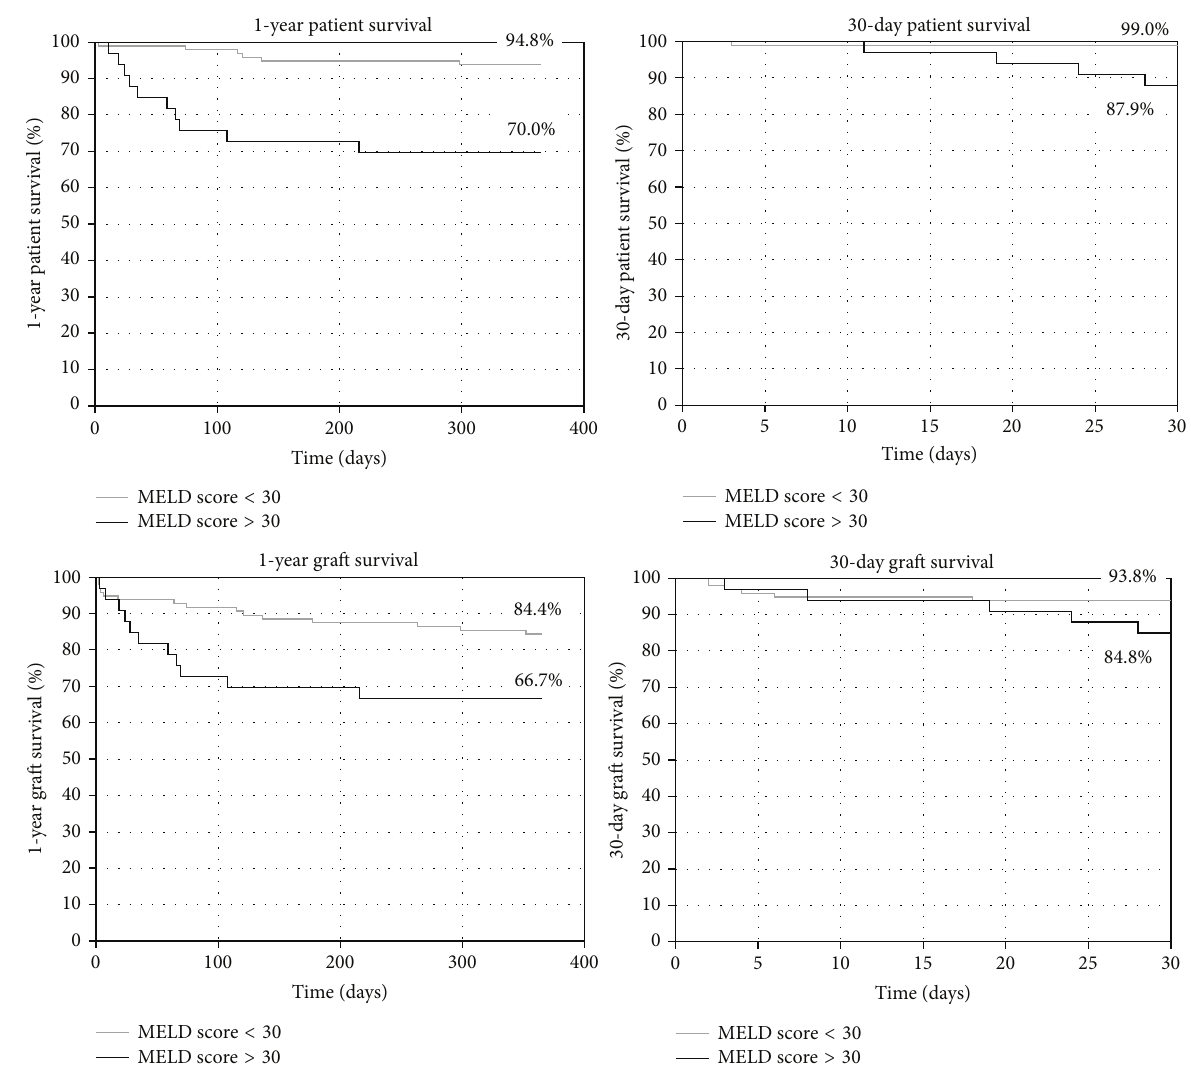
Figure 2: Patient and graft survival.